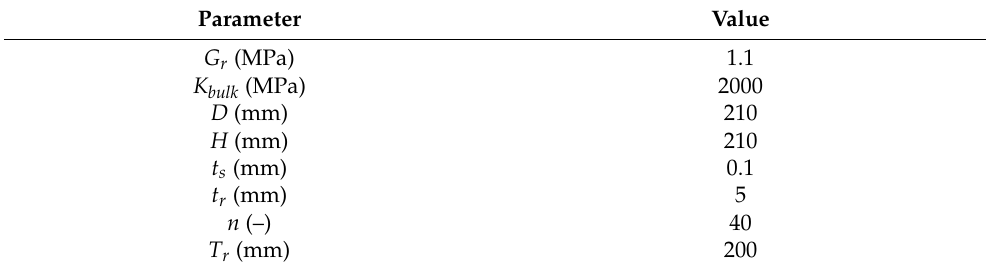
Table 5. Constant parameters assumed in the DEA